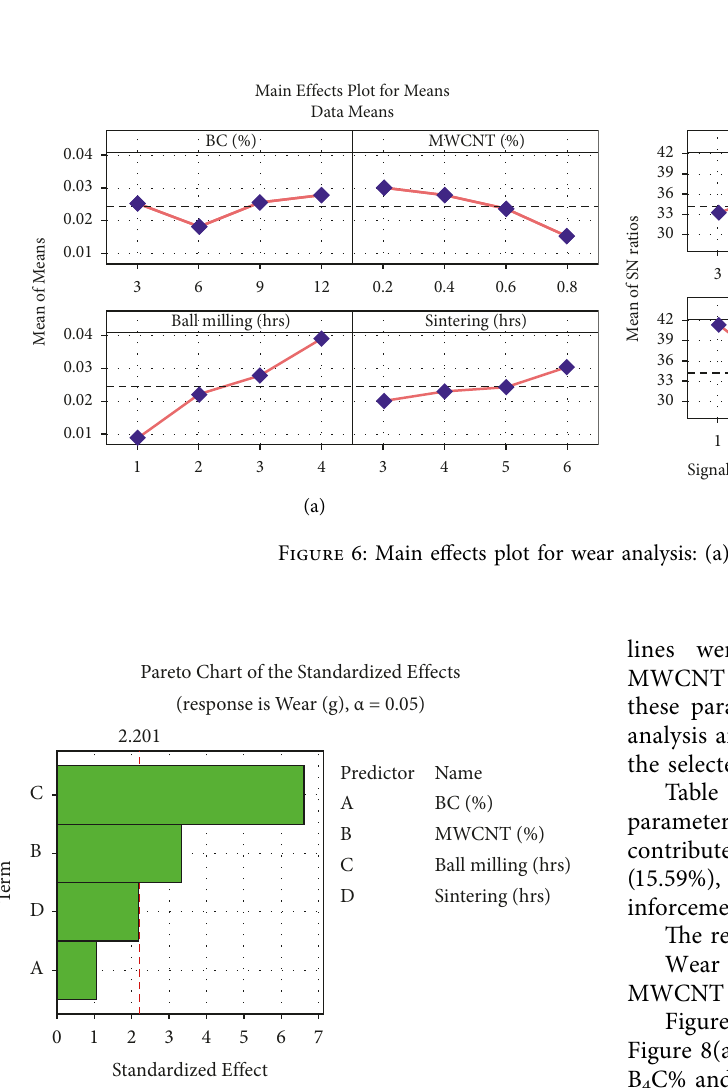
Figure 7: Pareto chart for wear